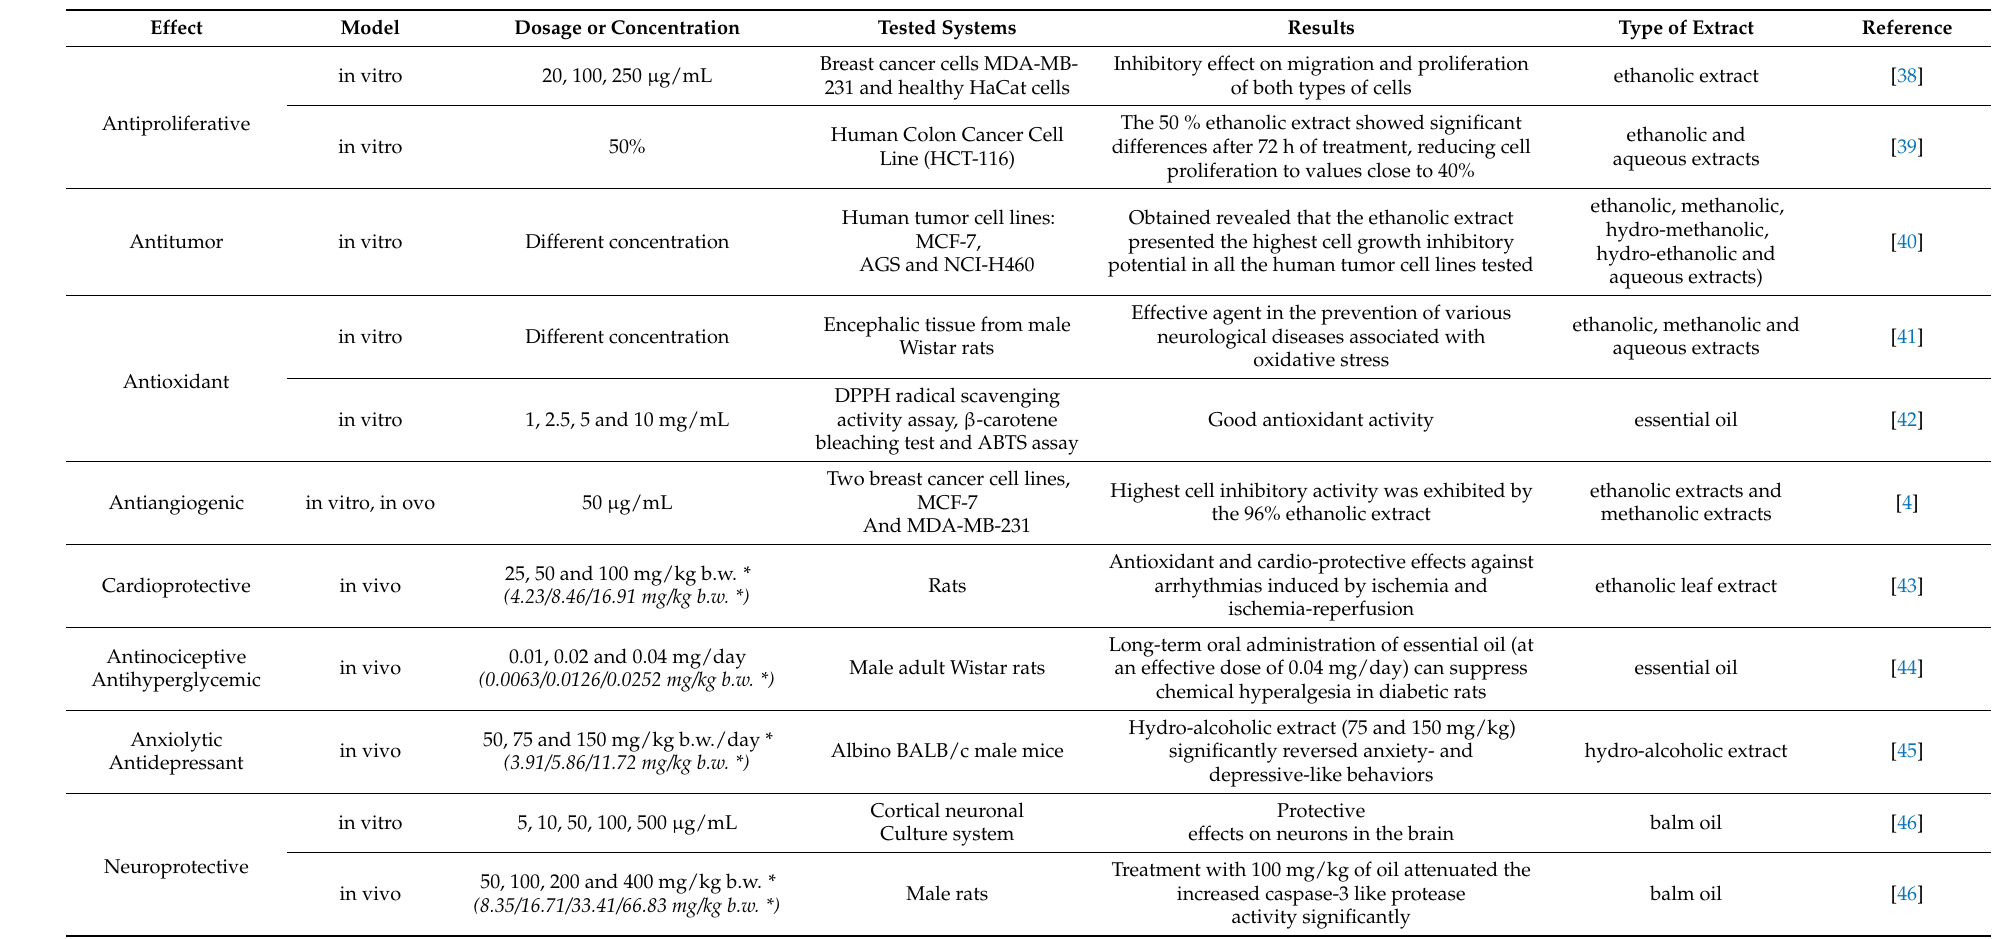
Table 4. Pharmacological effects reported from Melissa officinalis